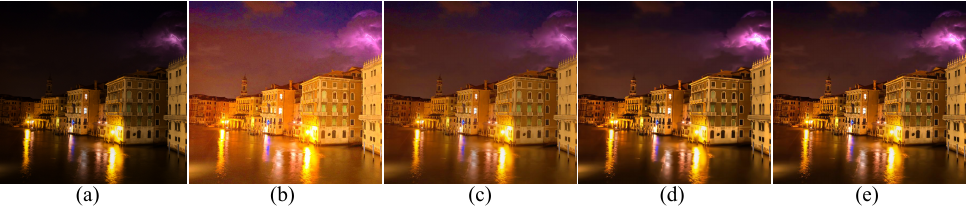
Figure 12. Ablation study for components of the CLAR model. ( a ) Input, ( b ) CLAR without + S y (cid:13) (cid:13) ∇ y L (cid:13) (cid:13) 2 S x (cid:107)∇ x L (cid:107) 2 , ( c ) CLAR without T x (cid:107)∇ x R (cid:107) 2 F F ( e )